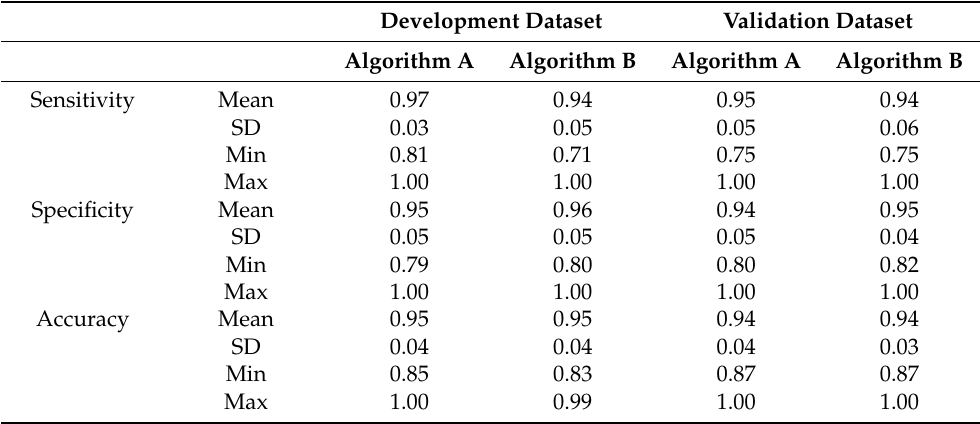
Table 2. Sensitivity and specificity of Algorithm A and Algorithm B for detecting lying down in the development dataset (n = 50) and the validation dataset (n = 47). Development Dataset Validation